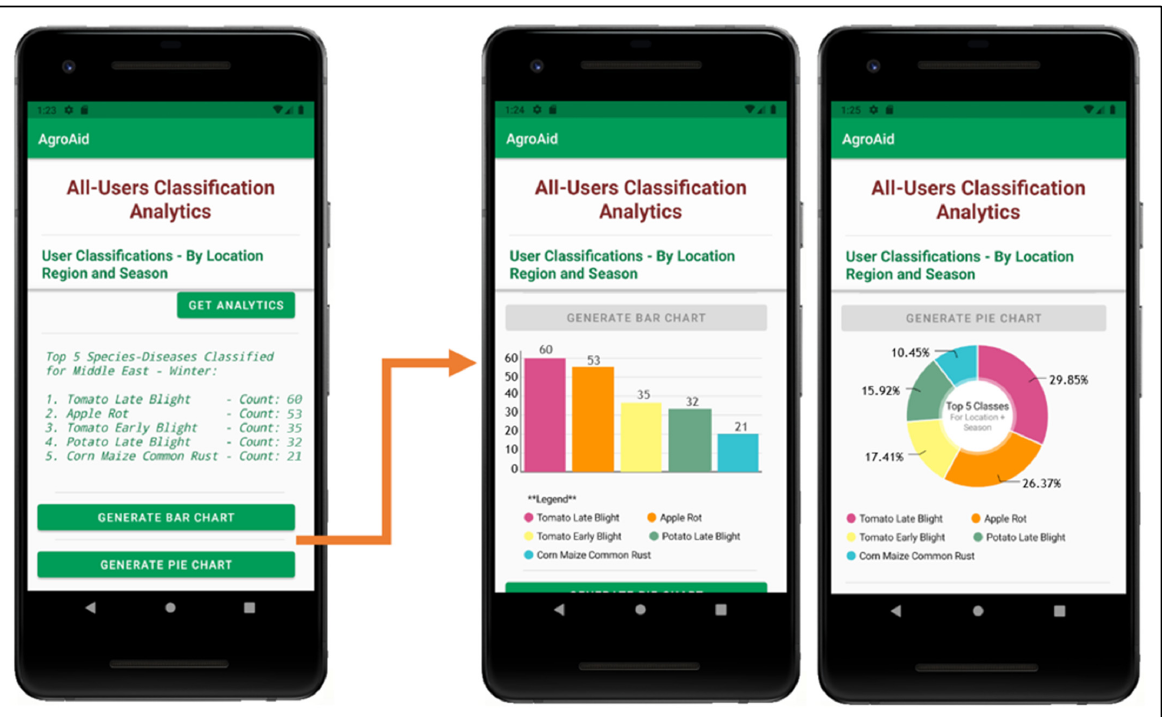
Figure 32. Example of generating bar and pie charts to visualize the generated spatiotemporal analytics.